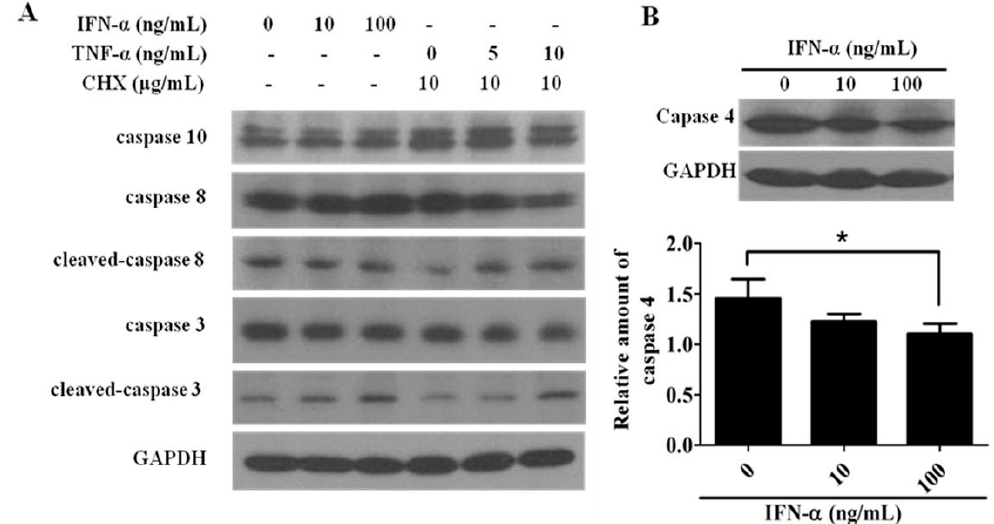
Figure 4. IFN- α mediated cell apoptosis in HeLa cells is also associated with ER stress-induced apoptosis. ( A ) IFN- α does not activate the extrinsic apoptotic pathway. The whole-cell lysates